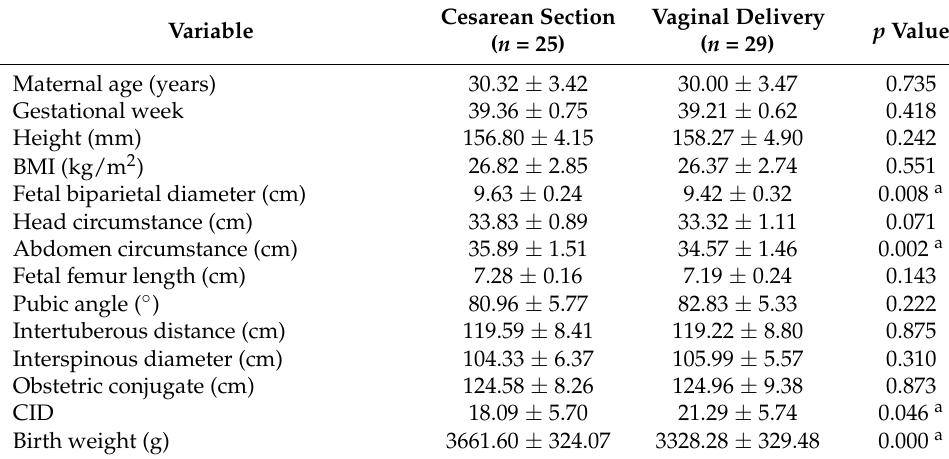
Table 4. The Parameters of the Cesarean Section and Vaginal Delivery Groups in prolonged stage of labour ( n =